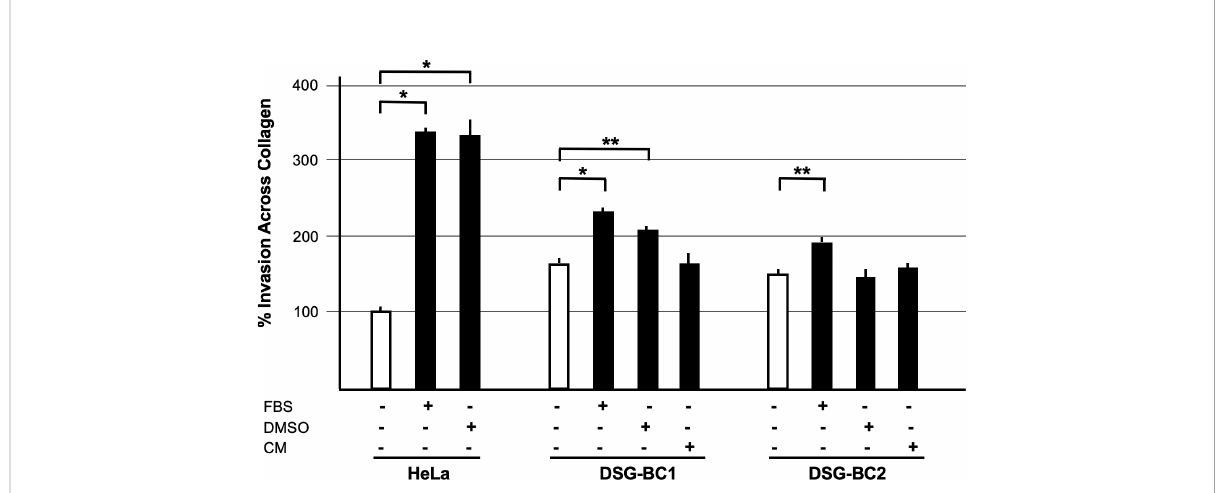
FIGURE 7 Breast cancer cells derived from a patient with obesity presented a higher invasion potential with respect to those derived from patient with normal weight. Invasion assay through collagen fi lled 8- m m pores. Cells were plated and, after adhesion, starved for 12 h before stimulation with the indicated attractants in the lower chamber as described in Materials and methods . HeLa cells were used as a positive control; 10% FBS supplemented growth medium was used as basal attractant in the lower chamber. Invasion of HeLa cells with this condition was considered 100% increase. Positive controls for invasion were 20% FBS (FBS), 80 nM PMA (PMA), or a 1:1 dilution of CM of each cell line. n=3. Brackets indicate comparisons with p value < 0.05 (*) or a p value < 0.01